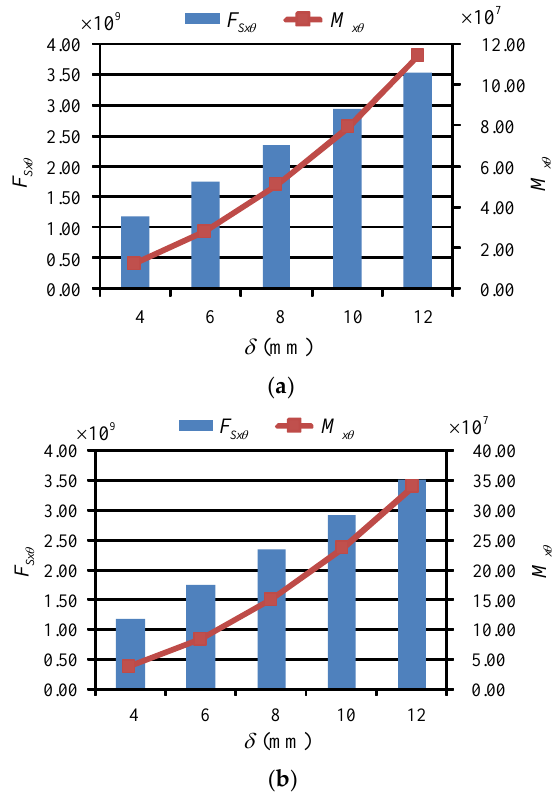
Figure 8. Effect of wall thickness δ on modes amplitudes with ( a ) B(2,1); ( b ) B(4,2).